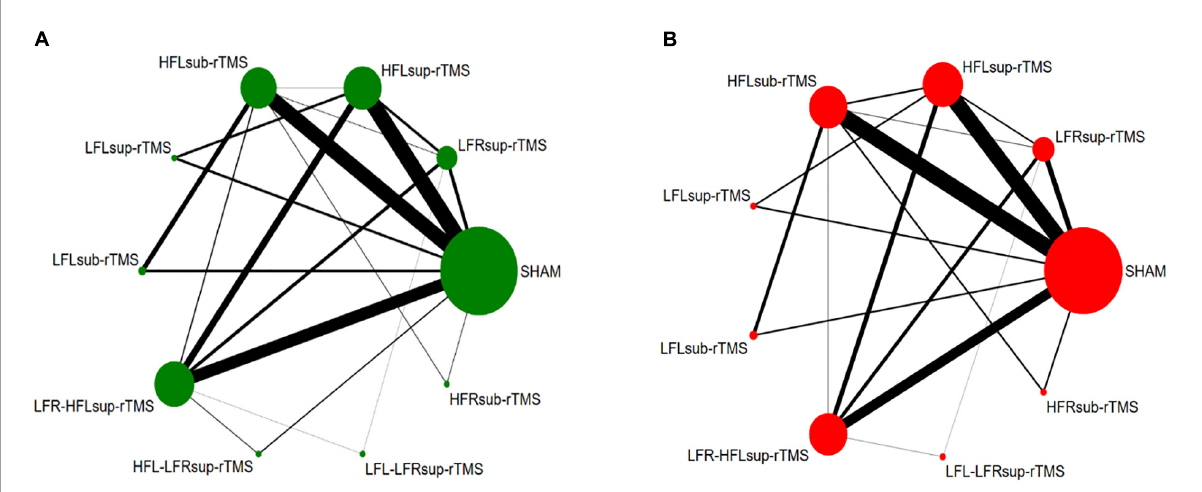
FIGURE3 Network plot for efficacy (A) and acceptability (B) : The width of the lines represents the number of trials comparing each pair of treatments. The size of each node represents the number of randomly assigned participants.